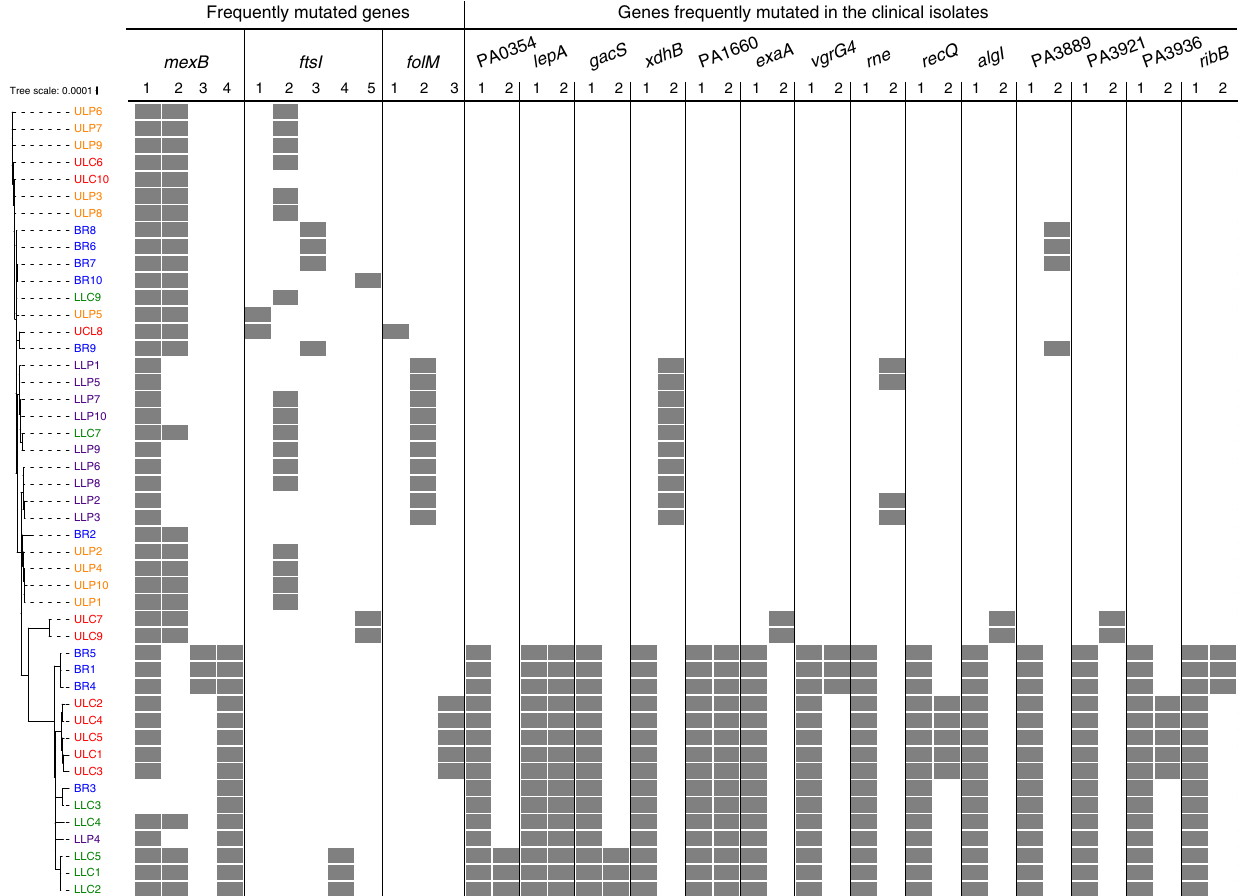
Fig. 4 Directional selection of genetic variations. Genes with multiple mutations and the corresponding clinical isolates harboring these mutations are shown. The top three genes harboring more than two mutations were mexB , ftsI , and folM . Furthermore, genes are listed with two mutations and those occurred in at least 15 isolates. The gray squares indicate the presence of the mutation in the respective clinical isolate. Color code of the lung isolates indicates from which sub-compartment they were recovered: main bronchus = blue, upper lobe central = red, upper lobe peripheral = orange, lower lobe central = green, and lower lobe peripheral =